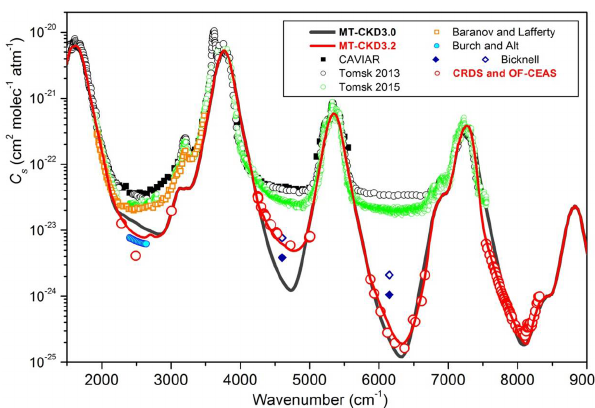
Figure 8. MT_CKD3.0 and 3.2 models (black and red solid lines, respectively) (Mlawer et al., 2012) of the water vapour self- continuum cross-sections, C S , in the 1500–9000cm − 1 range, com- pared to an exhaustive collection of experimental determinations: (i) FTS values reported by Baranov and Lafferty (2011) (orange squares); by the CAVIAR consortium (Ptashnik et al., 2011a) (black full squares); and from Tomsk2013 and Tomsk2015 experiments (Ptashnik et al., 2013, 2015) (black and green open circles, re- spectively). (ii) Results by Bicknell et al. (2006) from calorimetric- interferometry in air at 4605cm − 1 (blue open diamond corresponds to a measurement in air, blue full diamond is an estimation of the self-continuum contribution). (iii) Measurements by Burch and Alt (1984) near 2500cm − 1 using a grating spectrograph (open blue circles); (iv) present and previous measurements by CRDS and OFCEAS (red open